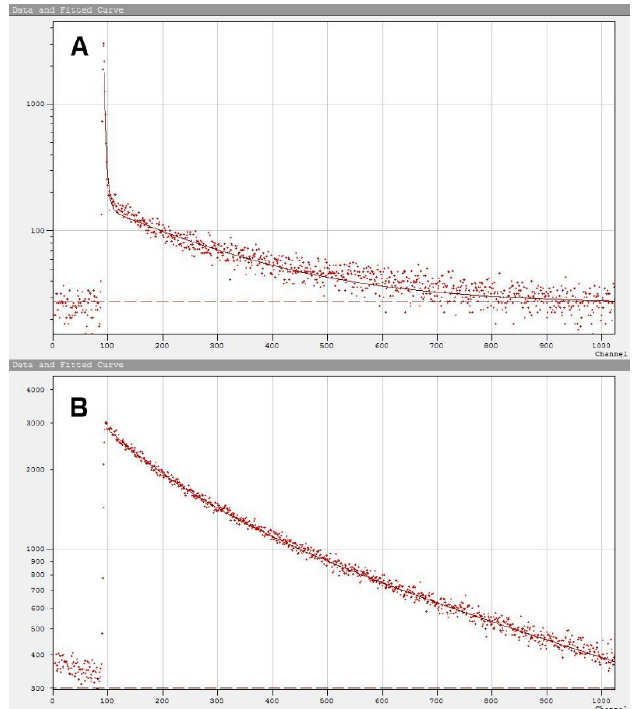
Figure 4. Fluorescence decays for A : e8 , B : e4 surfactants. For both surfactants, c / cmc = 6. Pyrene concentration is 4 × 10 -6 M ( e8 ), 1 × 10 -5 M ( e4 ), quencher concentration is 1x10 -4 M ( e8 ), 4 × 10 -4 M ( e4 ). The solid curves are results of the non-linear fit according to the equation (1).